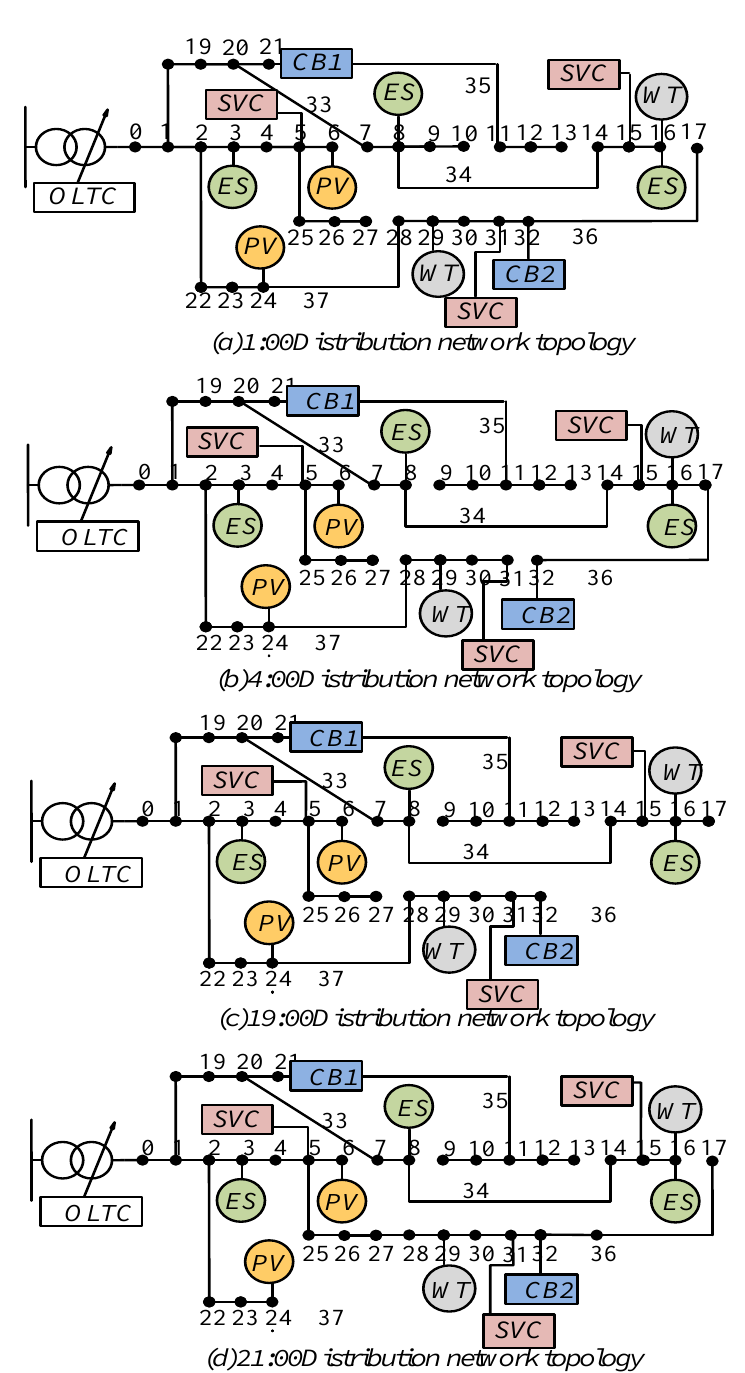
Figure 15. Distribution network topology change